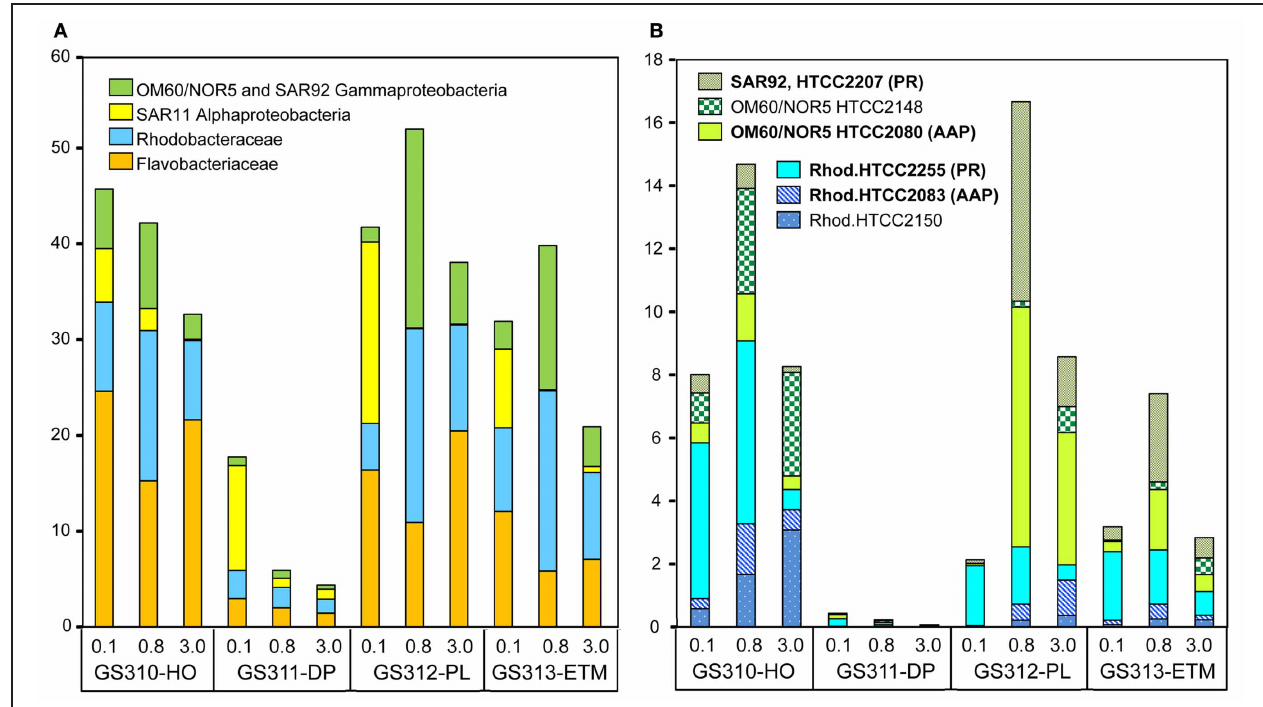
family Rhodobacteraceae (Rhodobacterales spp.) at sequence identities of > 90% (over > 70% of the alignment length). Genera shown in bold correspond to reference genomes containing genes associated with photoheterotrophy (PR, proteorhodopsin; AAP, aerobic anoxygenic photosynthesis). Sample names are encoded as described in the legend for Figure 3